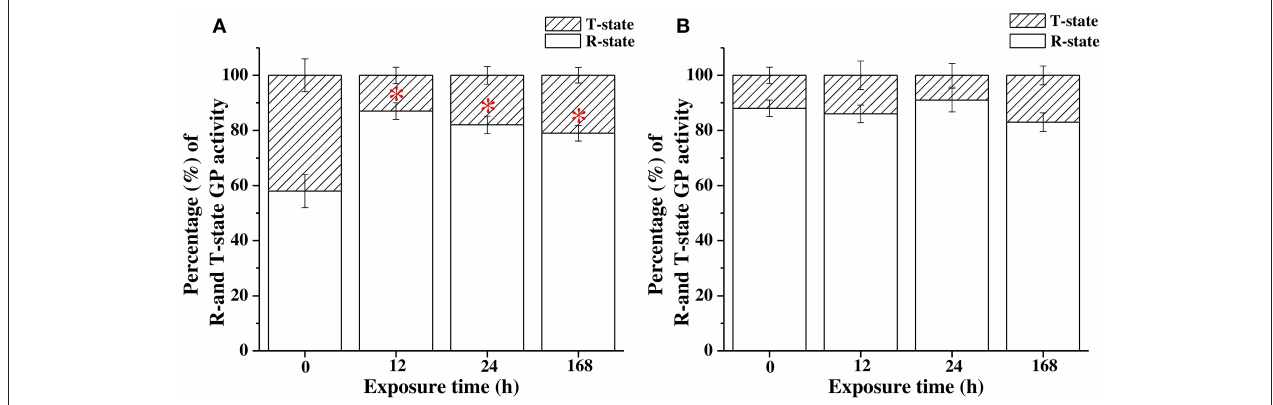
FIGURE 7 | The percentages of active form of GP activity in livers of (A) freshwater (FW) and (B) seawater (SW) milkfish in the hypothermal stress experiments after 18 ◦ C-exposure. Values are means ± SEM, n = 6. The percentage of the activity of GP active form: GP activity (AMP − )/total GP activity (AMP + ) × 100 (%). The asterisk indicates a significant difference compared to the 0h fish by one-way ANOVA (Dunnett’s comparison, P <